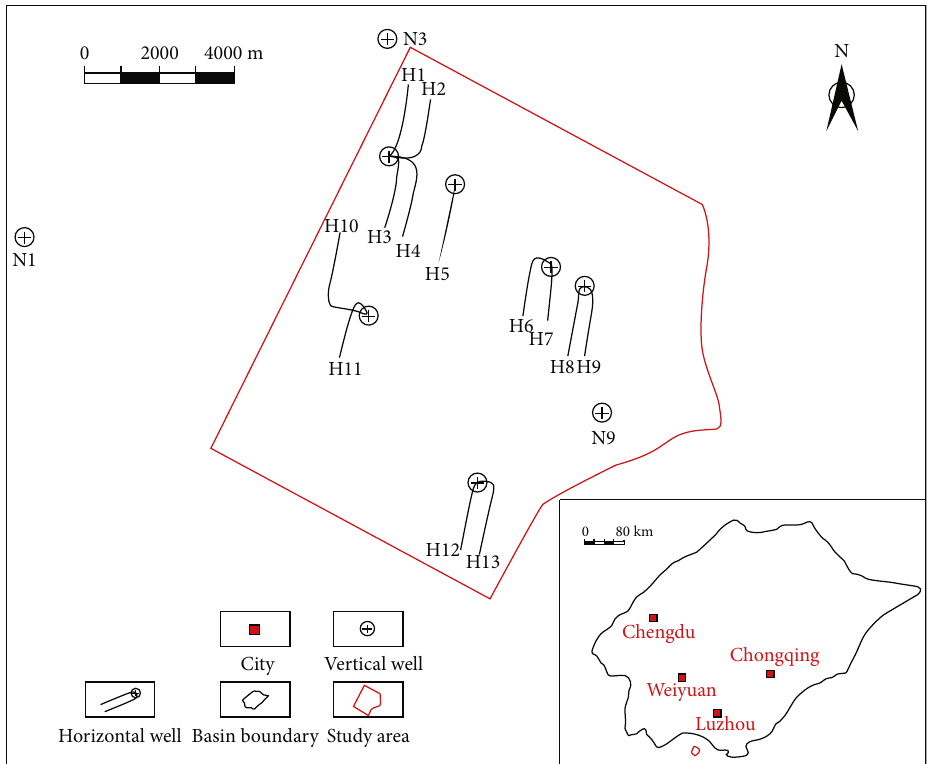
Figure 1: The study area and well